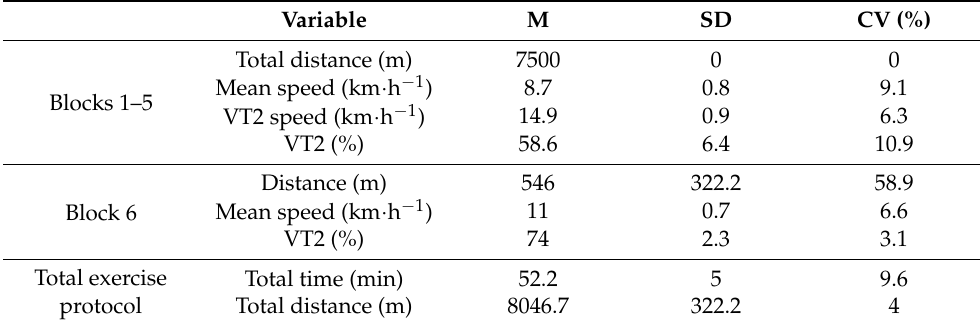
Table 1. Training load of the exercise protocol.